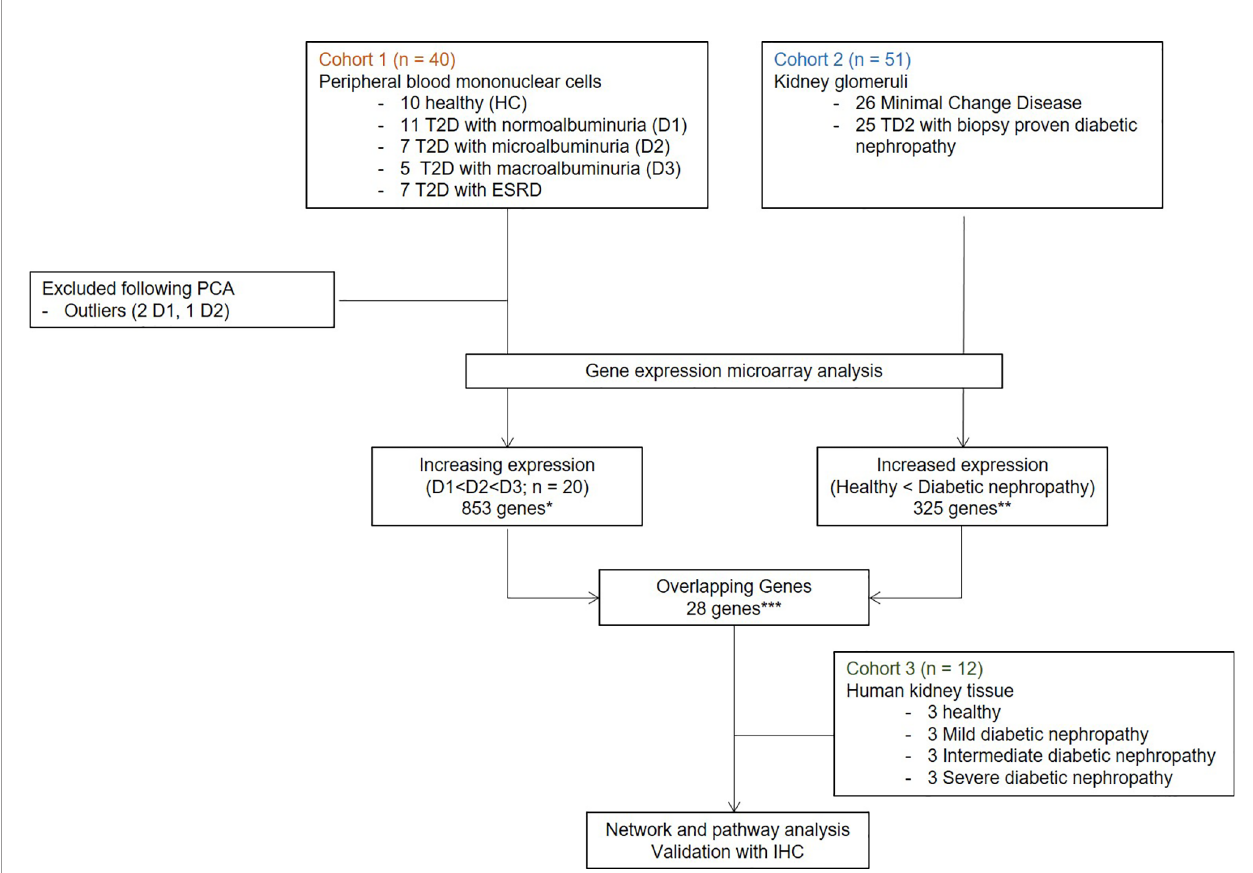
FIGURE 1 | Overall study design and work fl ow. Transcriptome pro fi ling with gene microarray performed on PBMCs from demographically matched sets of patients at different stages of DKDs (Cohort1) integrated with the publicly available microarray experiments on four microdissected glomeruli of patients with DKD (Cohort 2). Customized bioinformatics allowed for the selection of genes that correlated with DKD severity in both data sets by hypergeometric enrichment. Network and pathway analysis was performed with signi fi cant overlapping genes. One target with the most signi fi cant expression with DKD severity and the associated cell type was validated in an independent set of DKD samples (Cohort 3). IHC and IF for protein product performed on human kidney tissue. T2D, Type 2 diabetes; HC, healthy control; D1, normoalbuminuria; D2, microalbuminuria; D3, macroalbuminuria; IHC, immunohistochemistry; IF, immuno fl